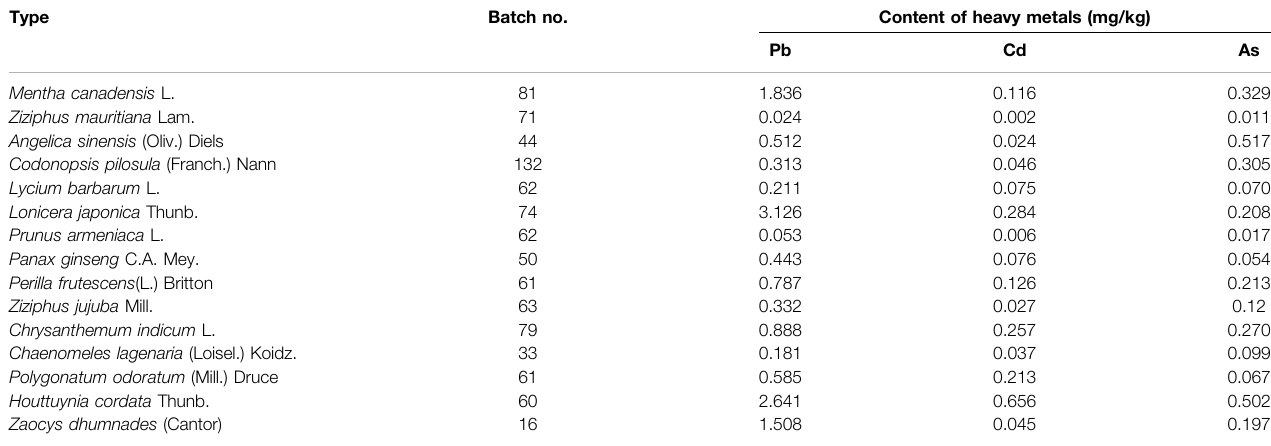
TABLE 2 | Average content of Pb and Cd in MFHV. Type Batch